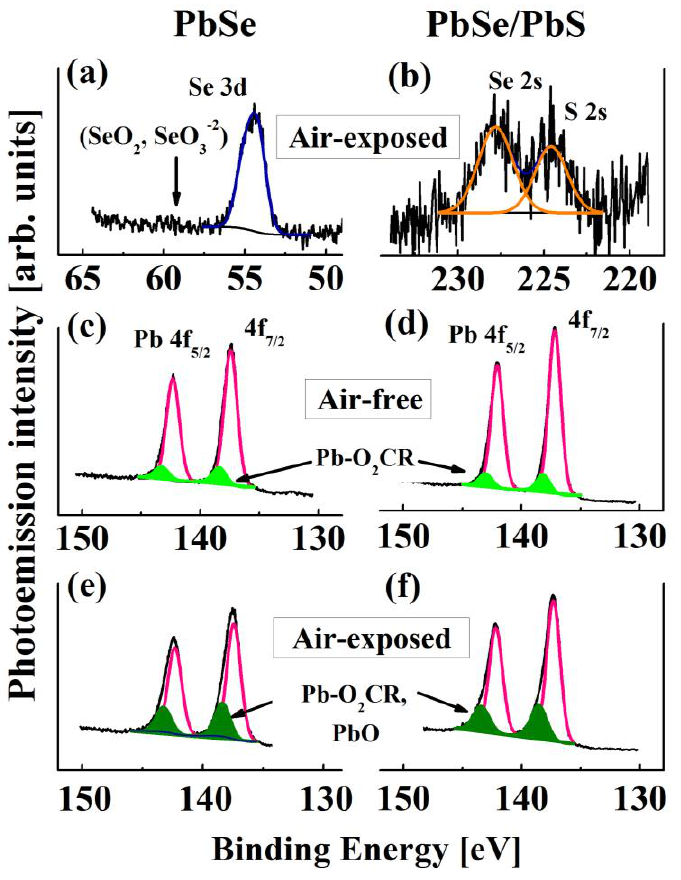
Figure 9. ( a ) XPS spectra of Se 3d peak (dark-blue) for air-exposed PbSe QDs. The location the oxidized-Se peaks (SeO 2 , SeO 3− ) is marked by an arrow; ( b ) XPS spectra of Se 2s and S 2s peaks for air-exposed PbSe/PbS QDs; ( c , d ) XPS spectra of Pb 4f peak of air-free PbSe and PbSe/ PbS QDs; ( e , f ) XPS spectra of Pb 4f peaks of the same QDs as in panels C and D after 50 min of air exposure. In ( c – f ) the curve-fitted individual contribution of Pb−Se/S and of Pb−O bonding is labeled in pink and green, respectively. The diameters of the examined PbSe and PbSe/PbS QDs were 2.5 ± 0.4 nm and 3.5 ± 0.5 nm, respectively.